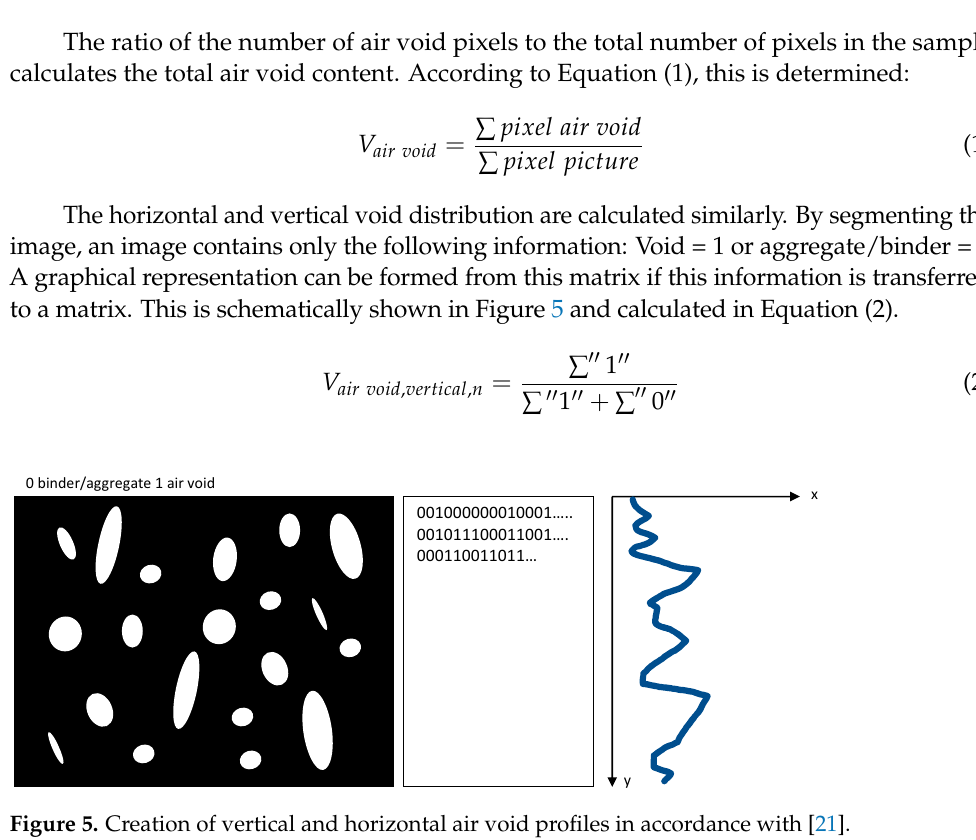
Figure 5. Creation of vertical and horizontal air void profiles in accordance with [21].